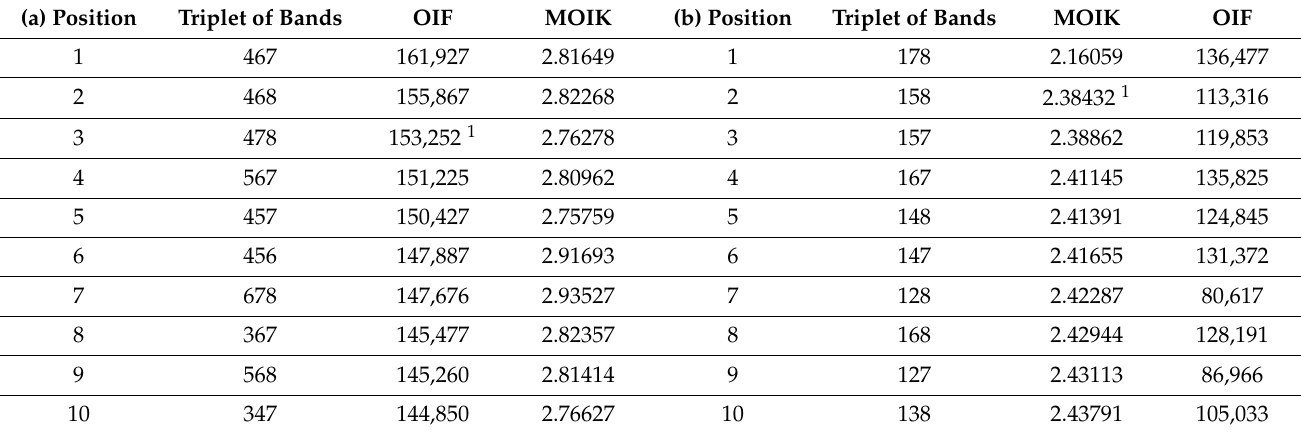
Table 5. List of information capacity of WorldView-2 (WV2) triplet of bands, ordered by: ( a ) optimum index factor (OIF) index and ( b ) MOIK (named after its creator, J.G. Moik)